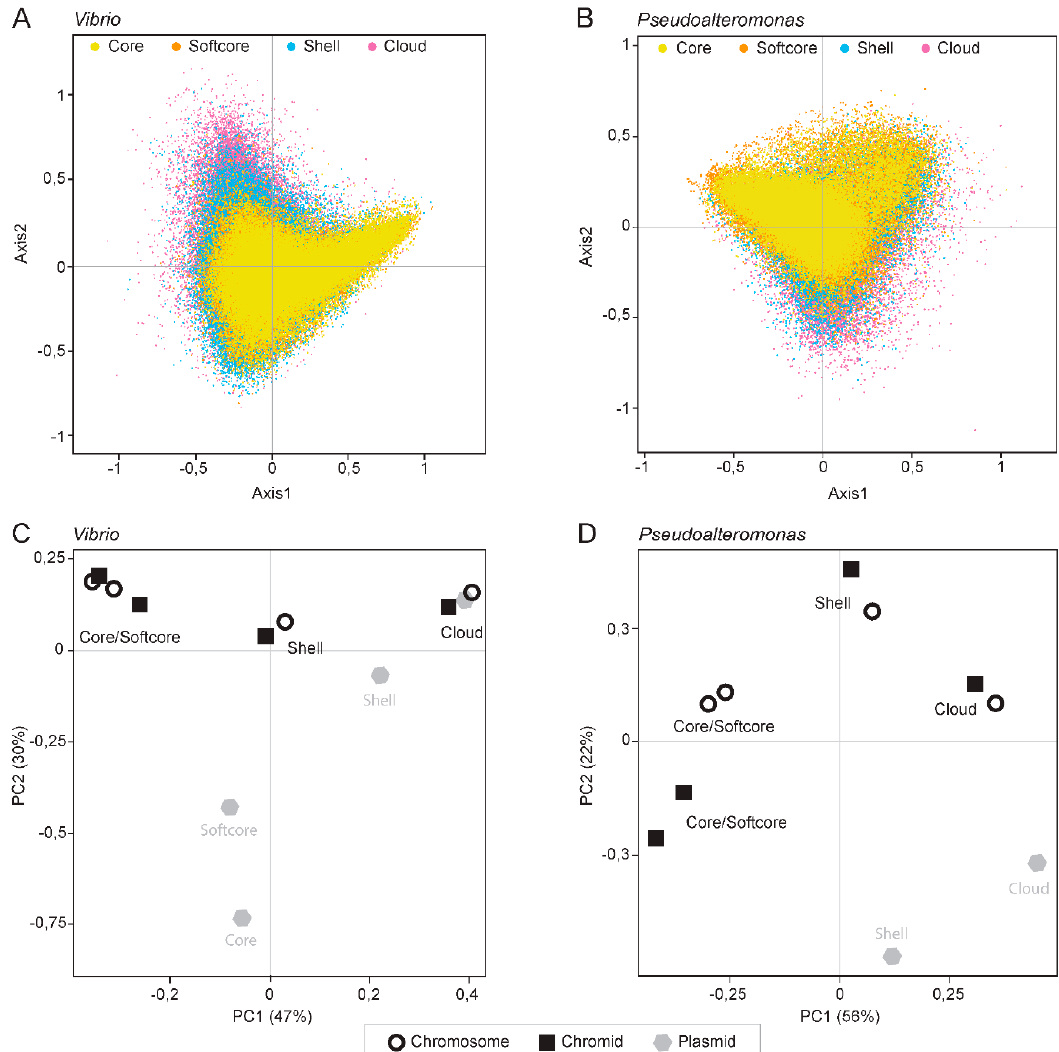
Figure 5. Correspondence analysis of relative synonymous codon usage (RSCU). The analyses are based on 50 Vibrio ( A ) and 26 Pseudoalteromonas ( B ) genomes. Core, softcore, shell and cloud genes are indicated with yellow, orange, blue and pink colors, respectively. The genes are distributed on primary and secondary axes which account for 10.98% and 8.07% in Vibrio and 10.97% and 7.52% Pseudoalteromonas of the total variation. Principal component analysis PCA) plots of the RSCU data from Vibrio ( C ) and Pseudoalteromonas ( D ) are shown. Both type of plots show that codon usage is specific for each pangene category rather than type of replicon.